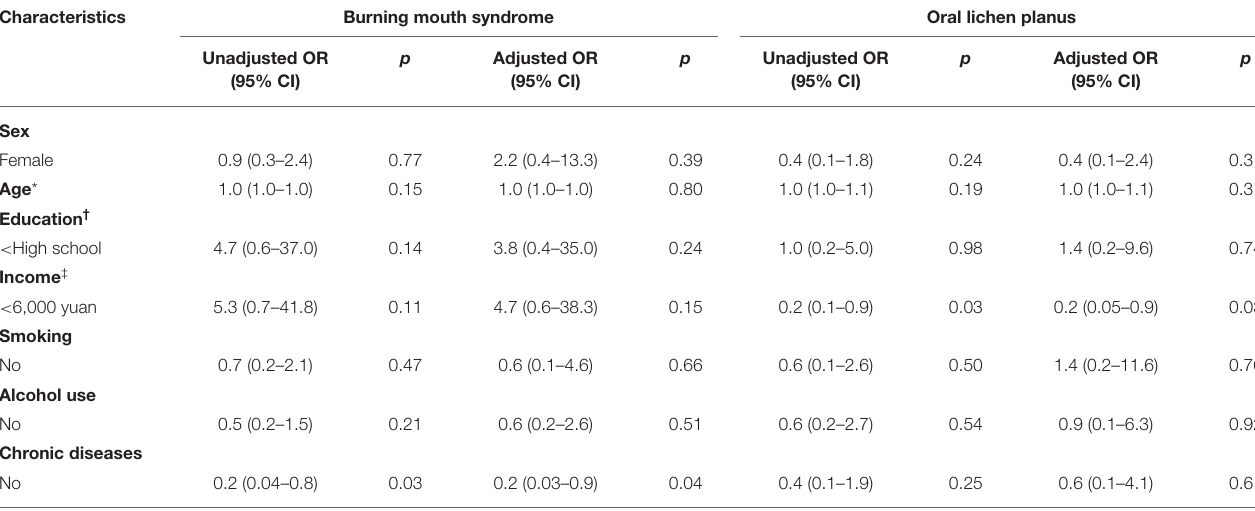
TABLE 4 | Characteristics associated with burning mouth syndrome or oral lichen planus. Characteristics